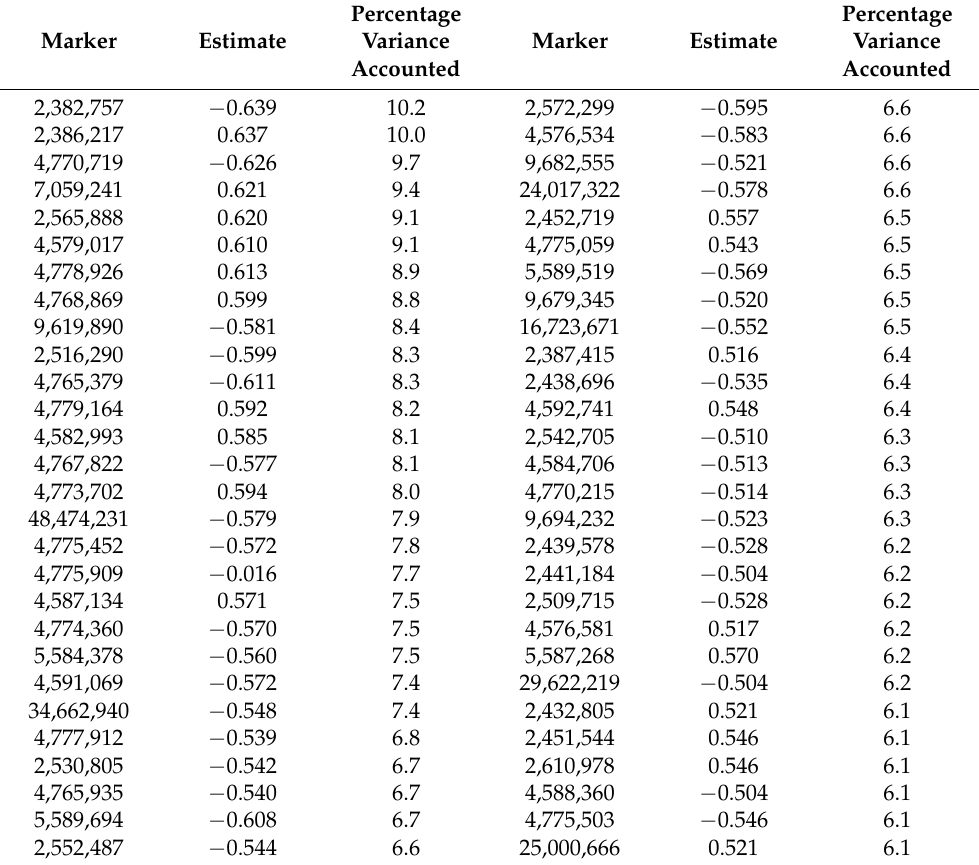
Table 4. Selected molecular markers (significant at the 0.001 level) related to the seed